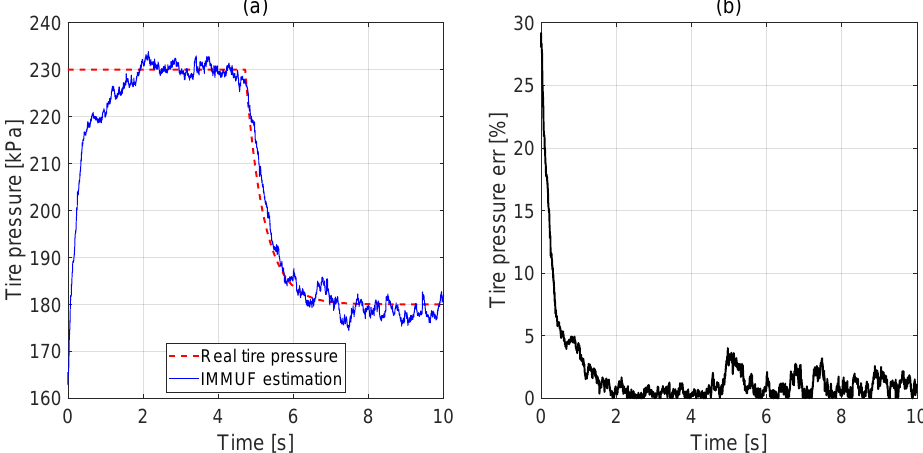
Figure 10. ( a ) Estimation of tire pressure with abrupt change of tire inflation pressure and ( b ) estimation